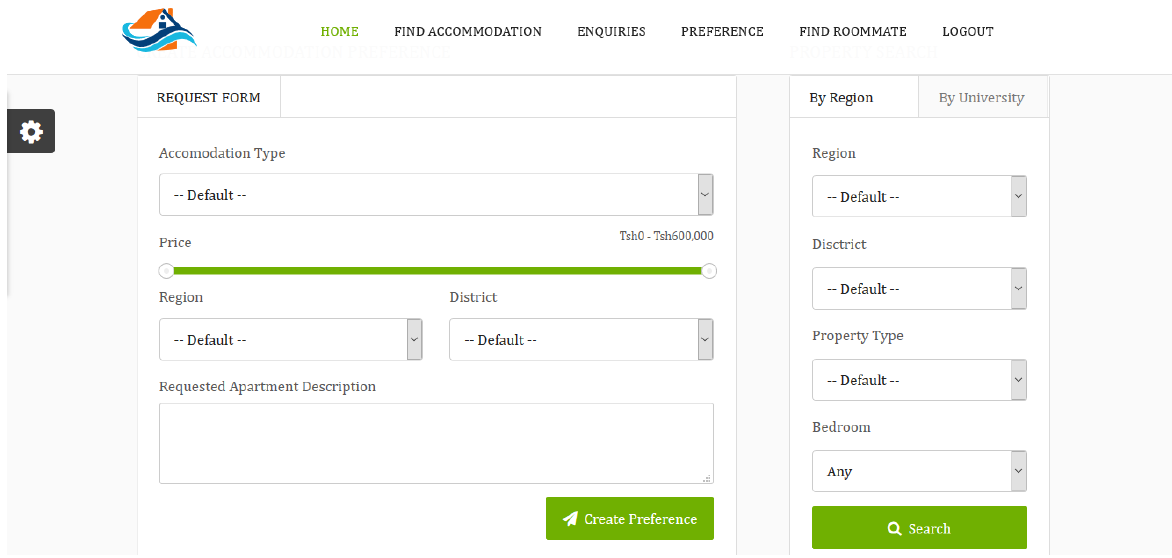
Figure 18. Interface for Creating Accommodation